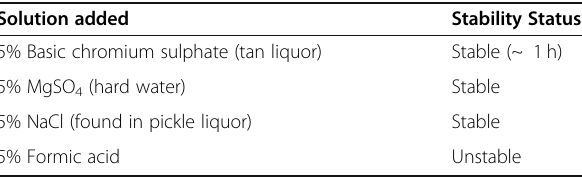
Table 6 Stability of 10% Sulfonated S. indicum fatliquor towards pickle liquor, tan liquor and hard water Solution